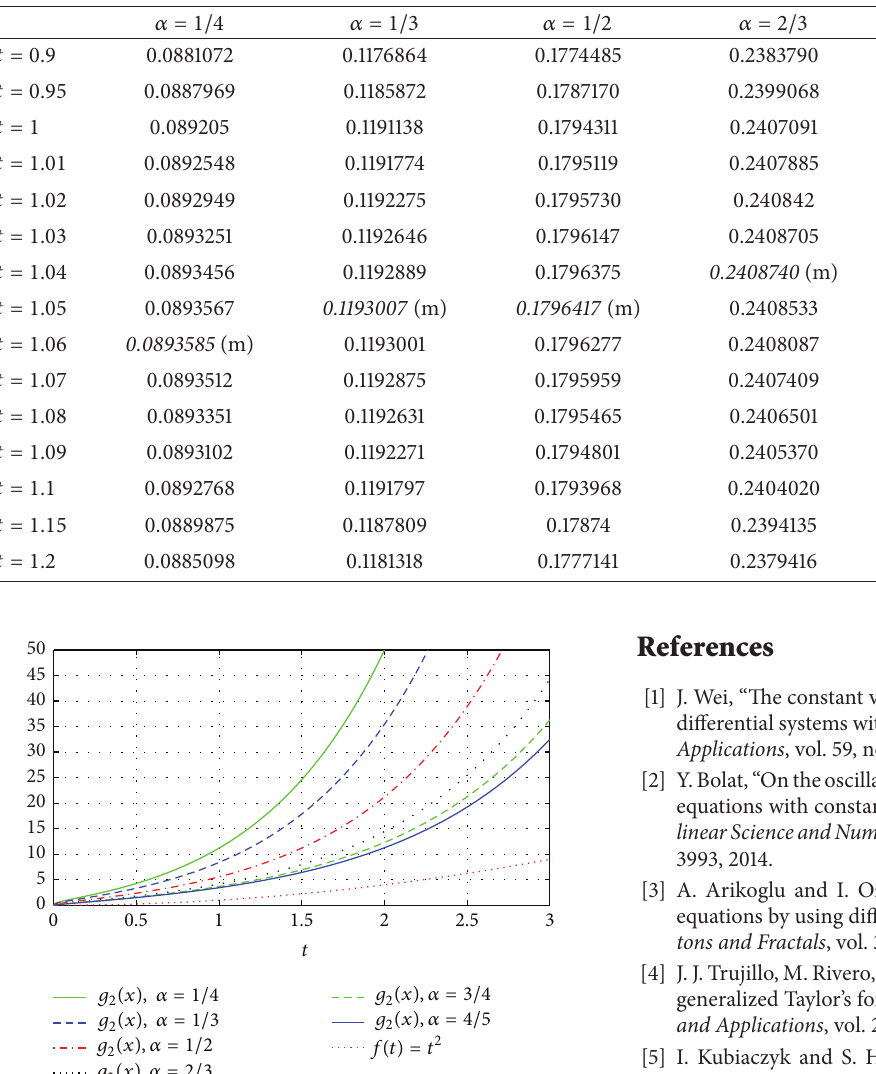
Table 1: Values of 𝑔(𝑡) with different 𝛼 .